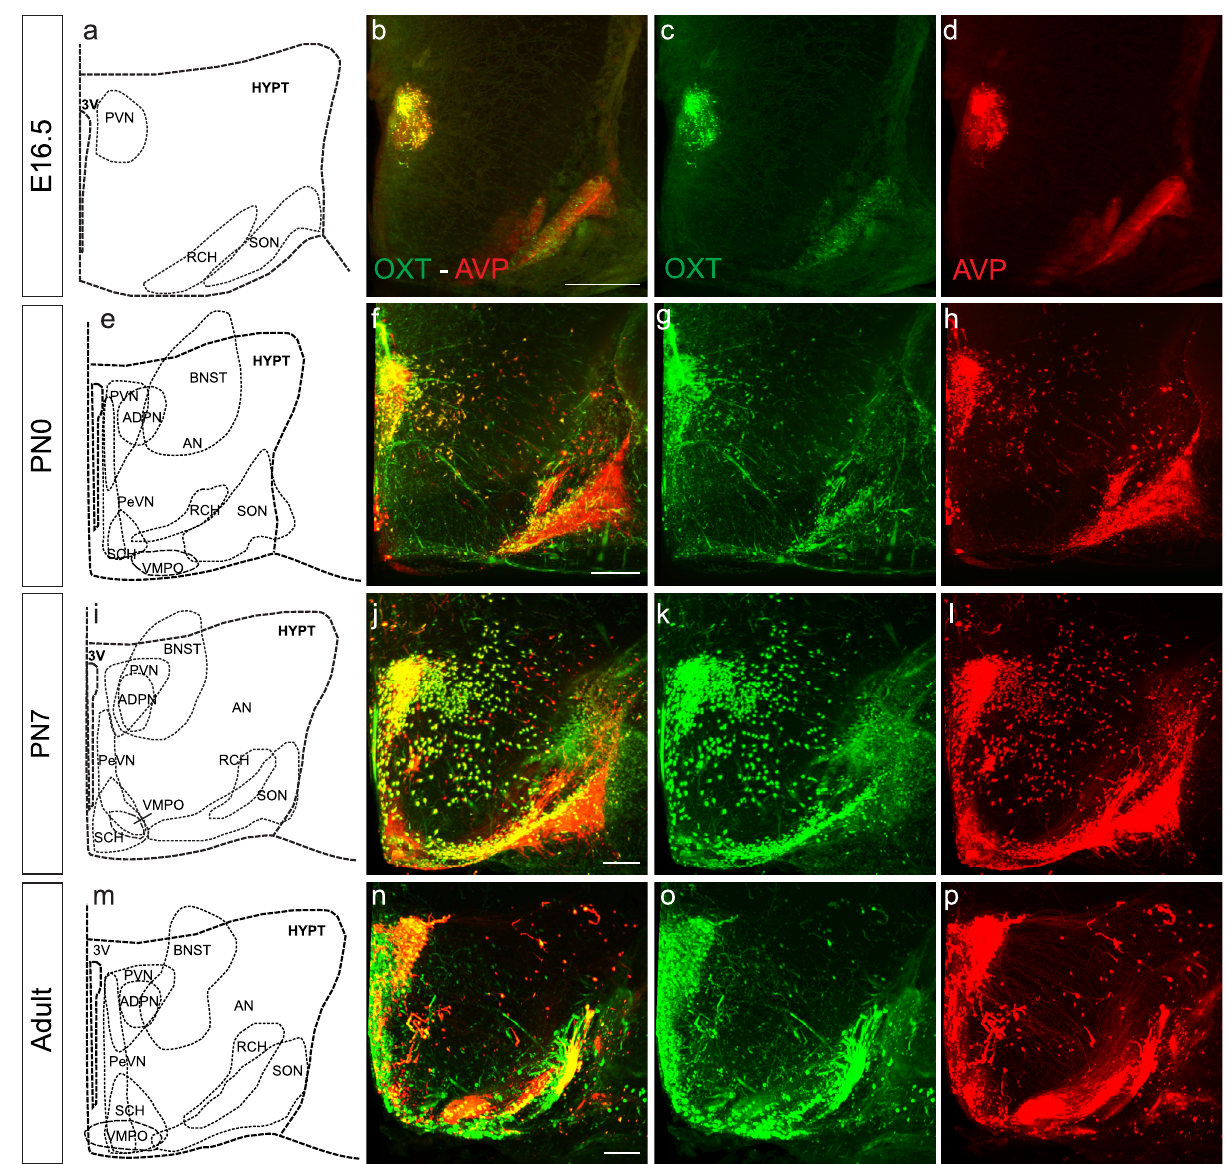
Fig. 2 OXT and AVP expression patterns in the developing mouse hypothalamus. Snapshot of a whole-brain stained with an anti-OXT (green) and anti- AVP (red) antibody. Brain coronal sections at multiple developmental stages: E16.5 ( a – d ), PN0 ( e – h ), PN7 ( i – l ) and young adult ( m – p ). 3v third ventricle, PeVN periventricular nucleus, ADPN anterodorsal preoptic nucleus, BNST bed nucleus of stria terminalis, VMPO ventromedial preoptic nucleus, SON supraoptic nucleus, PVN paraventricular nucleus, RCH retrochiasmatic area, AN accessory nucleus, SCH suprachiasmatic nucleus. Scale bar: 200 µ